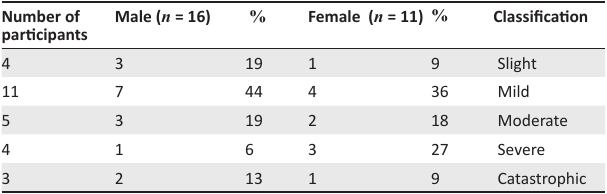
TABLE 3: Gender breakdown of percentage of overall disability and the classification according to the Tinnitus Handicap Inventory ( N = 27).